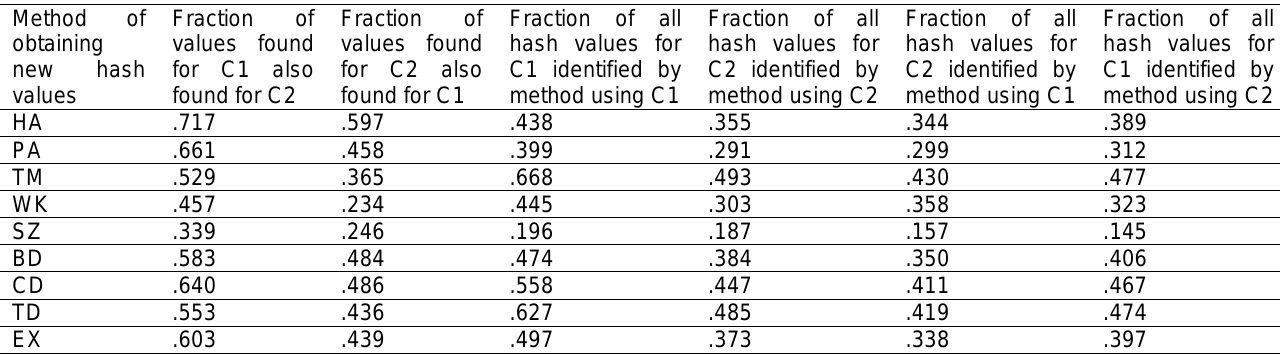
Table 9. Statistical comparison of hashes derived from partition of our corpus into two halves, where HA=hashes, PA=paths, TM=time, SZ=size, BD=bottom-level directory, CD=directory context, TD=top-level directory,